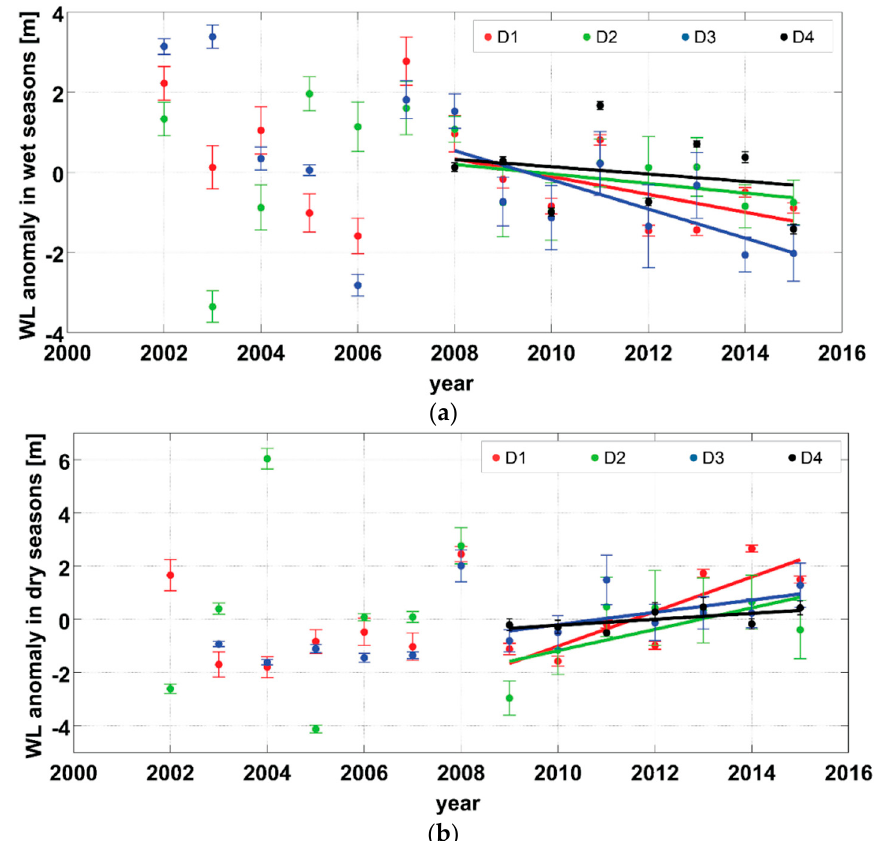
Figure 7. ( a ) A decreasing trend of mean WL in wet seasons from 2008-2015. The measurements have been removed the mean itself for comparison. (red: D1, green: D2, blue: D3, black: D4). ( b ) An increasing trend of mean WL in dry seasons from 2009–2015 for D1–D4.